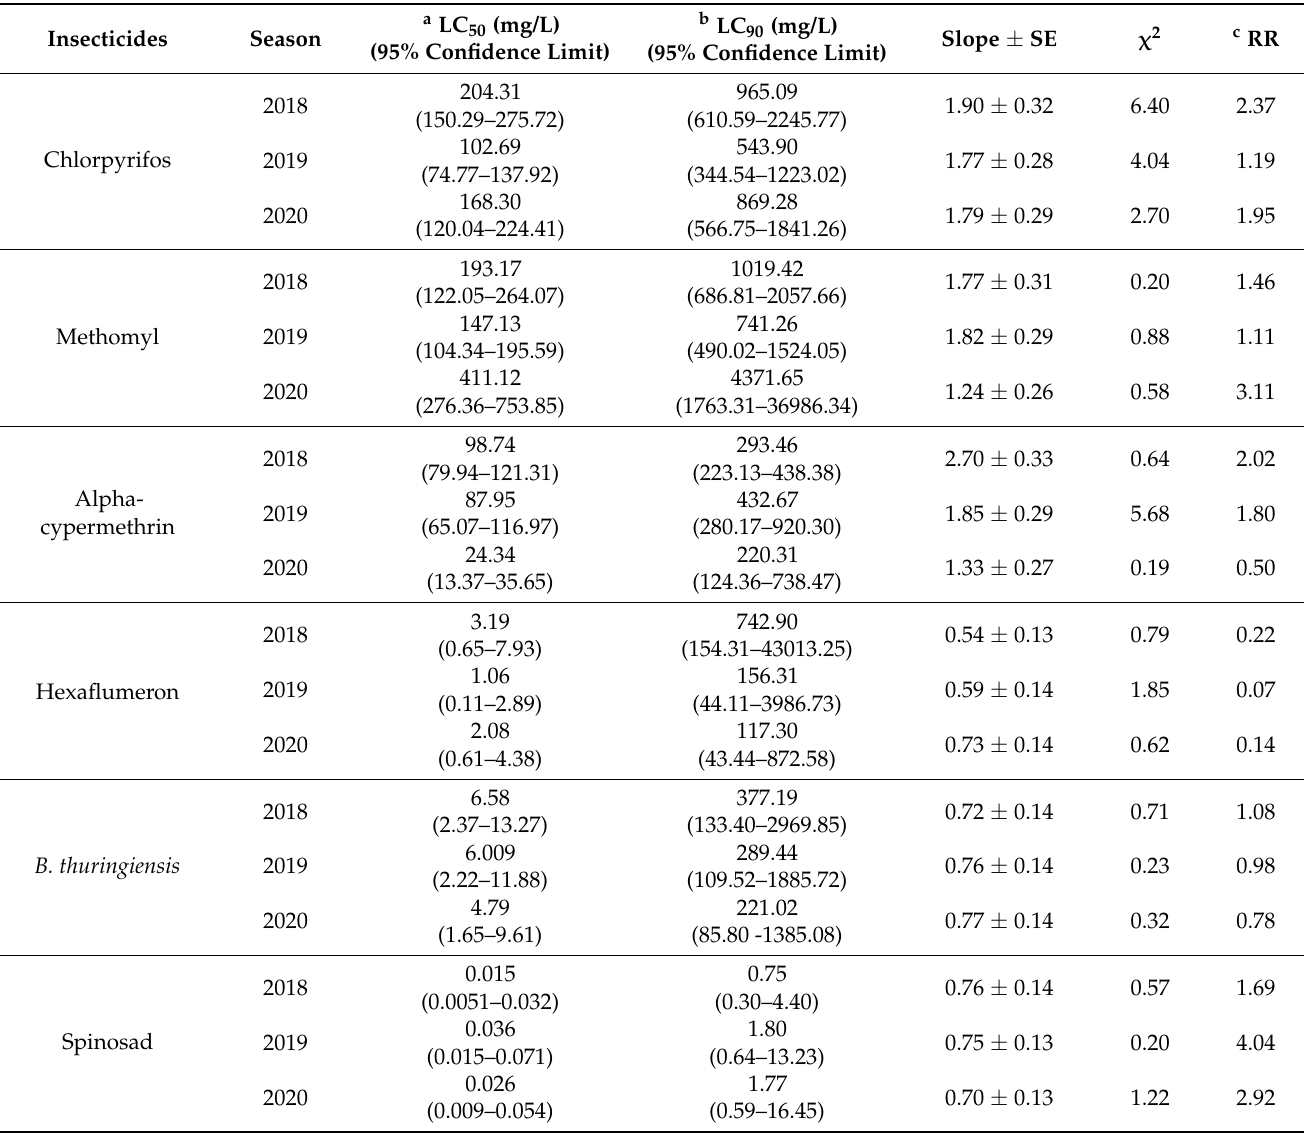
Table 3. Susceptibility of fourth instar larvae of Fayoum field strain of Spodoptera littoralis to six insecticides over three consecutive seasons (2018 to 2020). Egg masses of S. littoralis , collected over three consecutive seasons (2018 to 2020), were kept in the rearing room until the fourth instar larvae. Six concentrations of each tested insecticide were prepared, then castor bean leaves were immersed in each concentration for 20 s. For each concentration, 50 larvae were used to calculate the LC 50 , LC 90 and the resistance